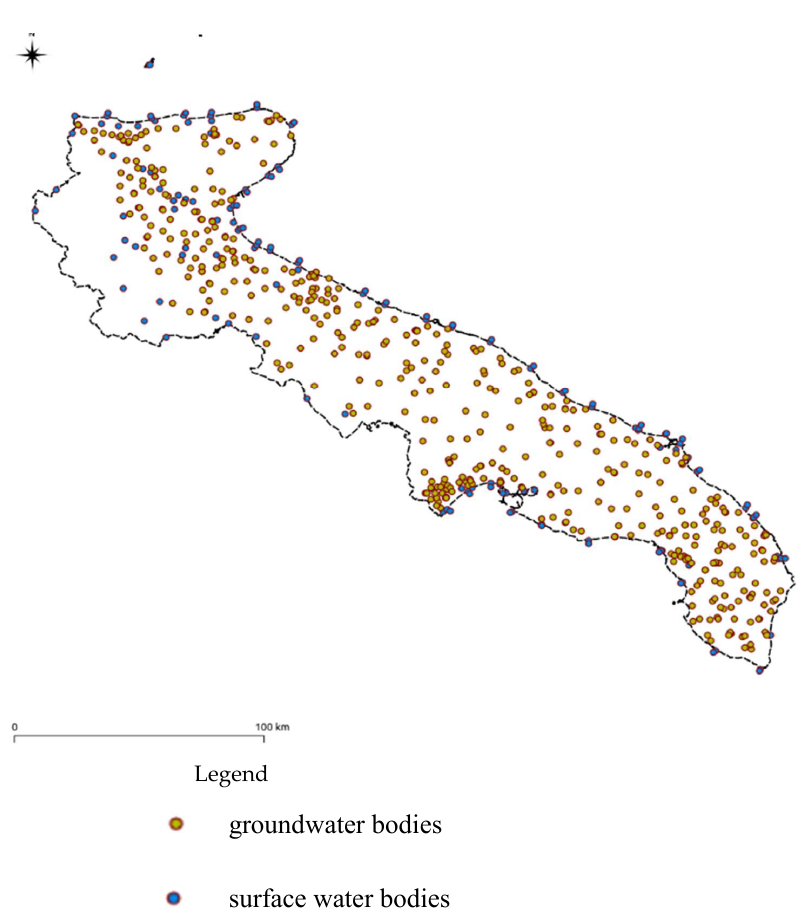
Figure 11. All selected monitoring stations subdivided in groundwater (yellow dots) and surface water bodies (blue dots).